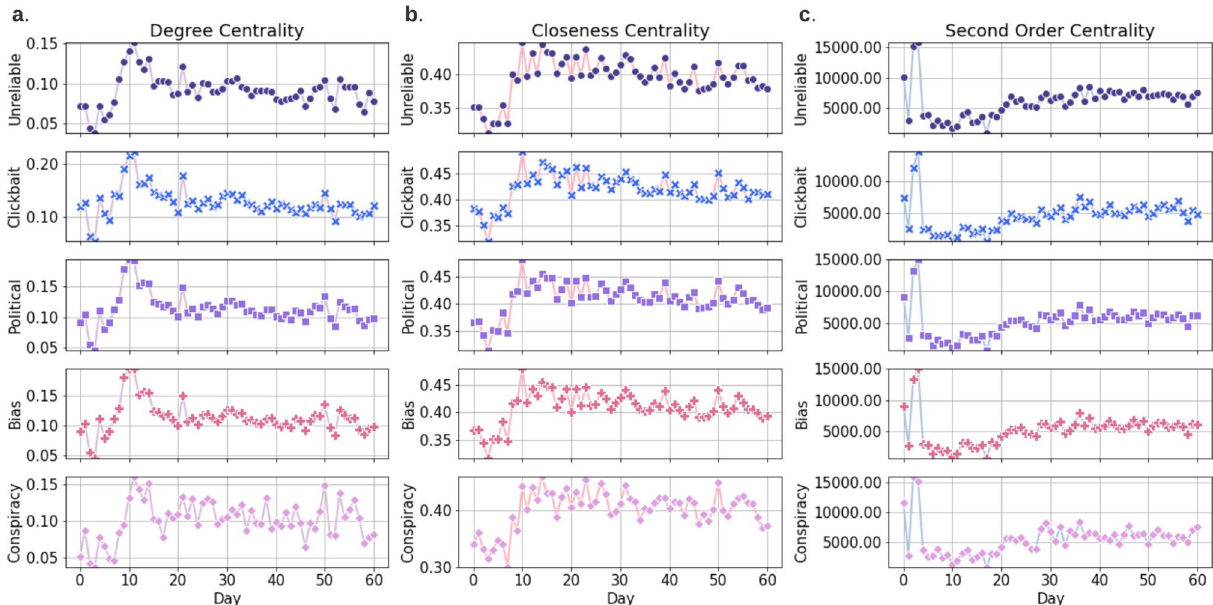
Figure 2. Misinformation network centrality measures. The mean value curves of the degree centrality ( a ), closeness centrality ( b ) and second order centrality ( c ) for misinformation networks of 60 days across five different misinformation categories: unreliable, clickbait, political, bias and